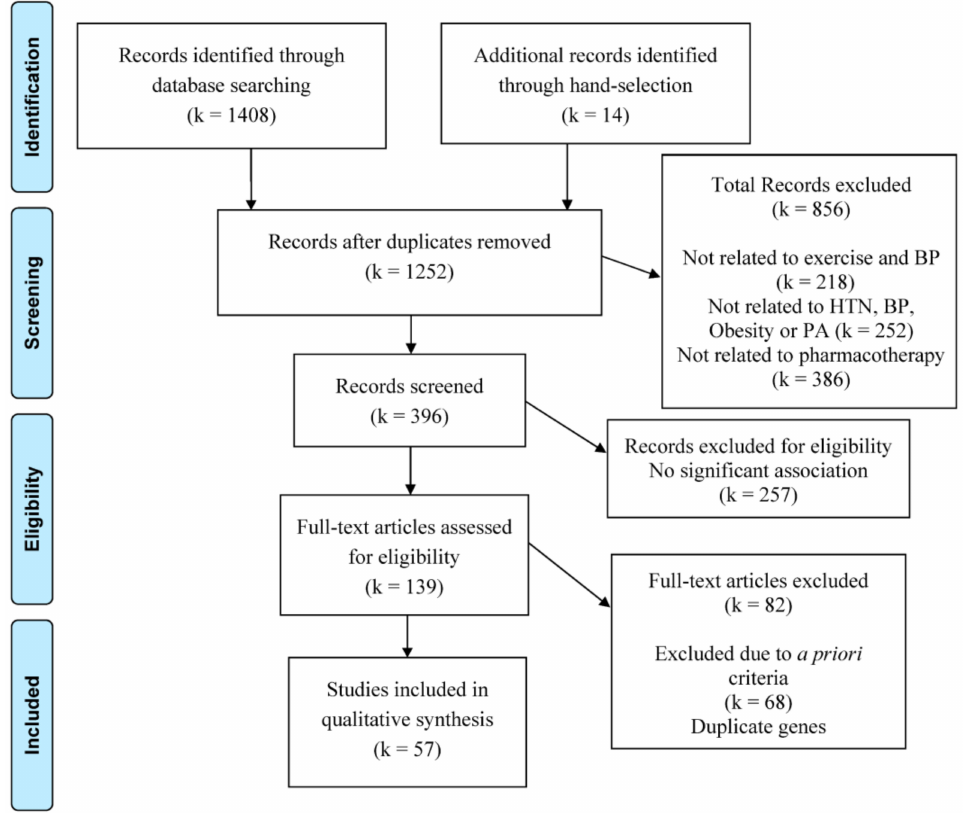
Figure 1. The systematic search trial selection process. BP: blood pressure; HTN: hypertension; PA: physical